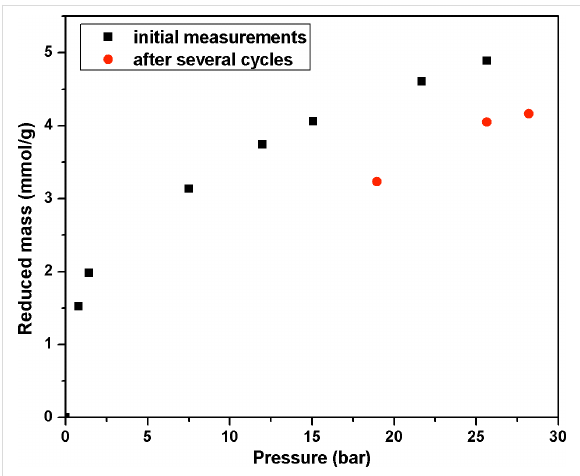
Figure 9: High pressure carbon dioxide adsorption isotherm at 25 °C for carbon tubes ( 4 ) carbonized at